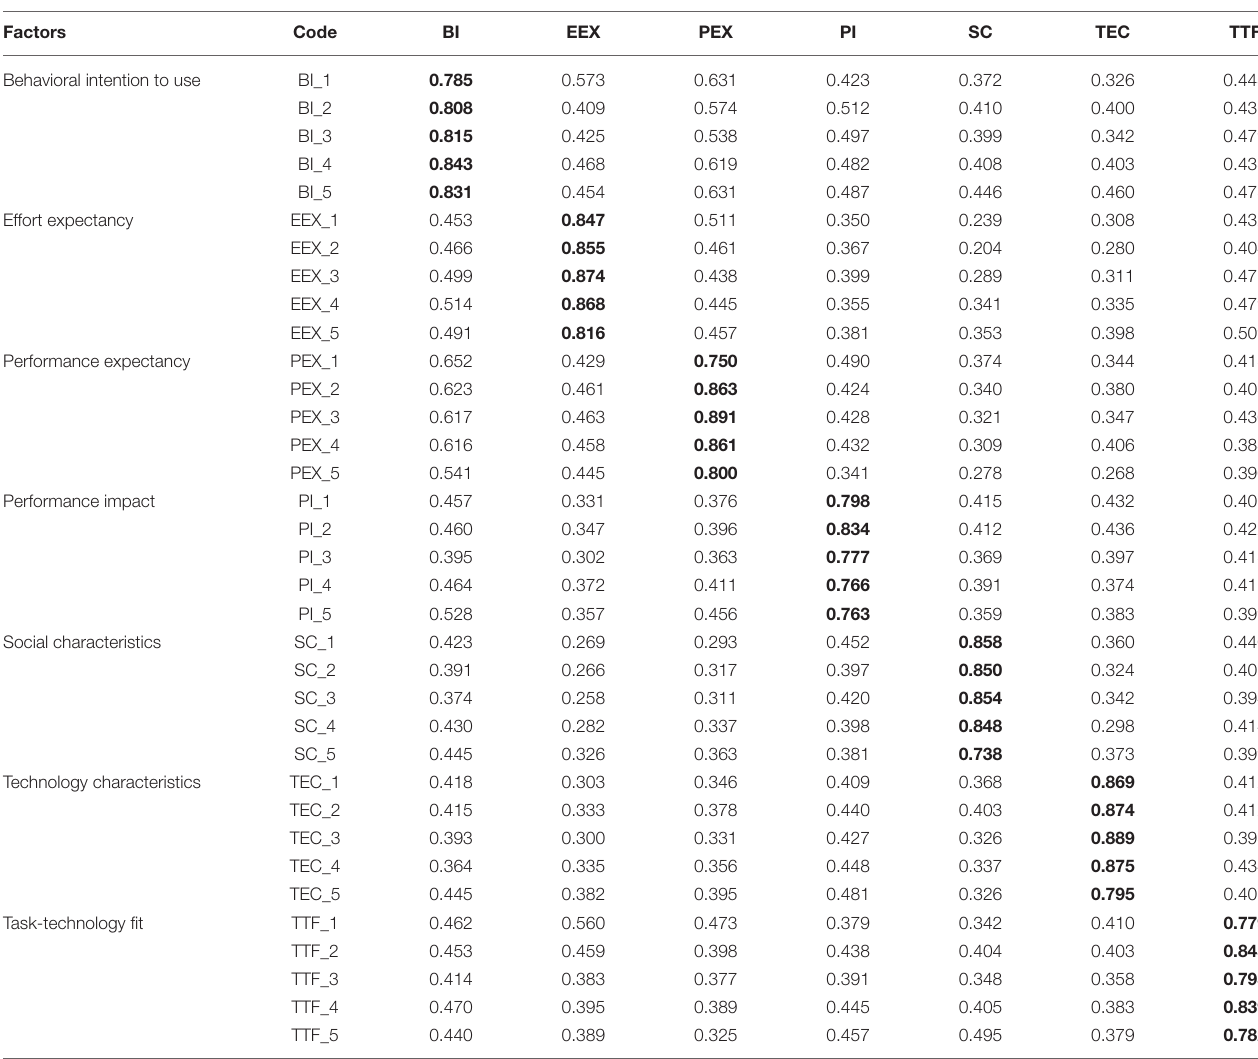
TABLE 5 | Measures for cross-loading and